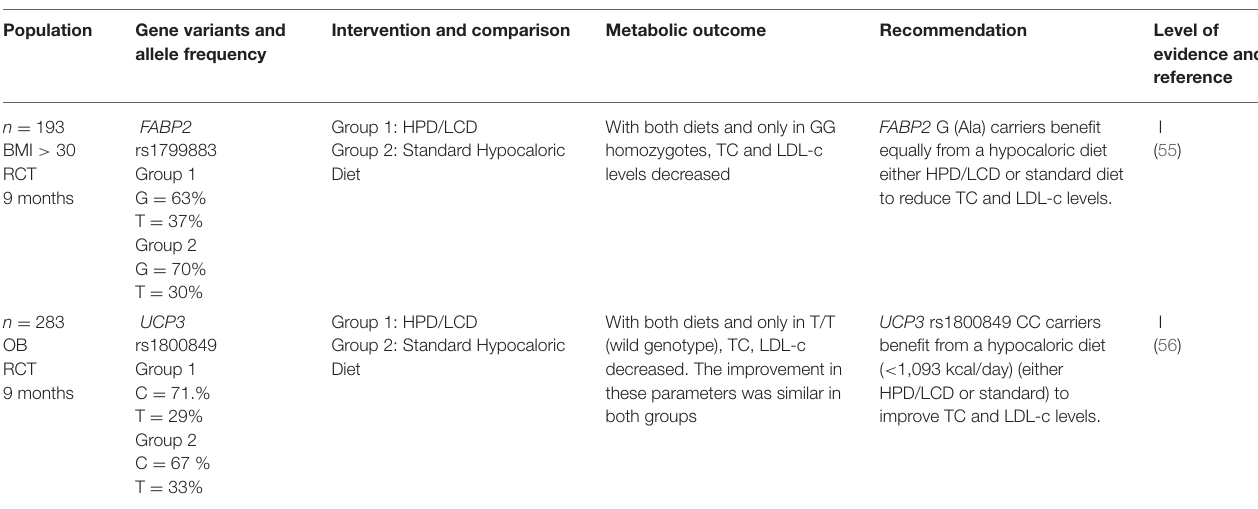
TABLE 4 | Gene variants interaction with dietary